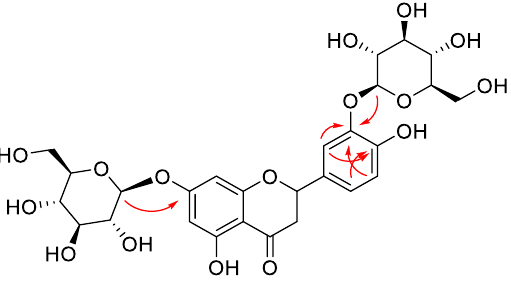
Figure 4. Key HMBC correlations of compound 3.